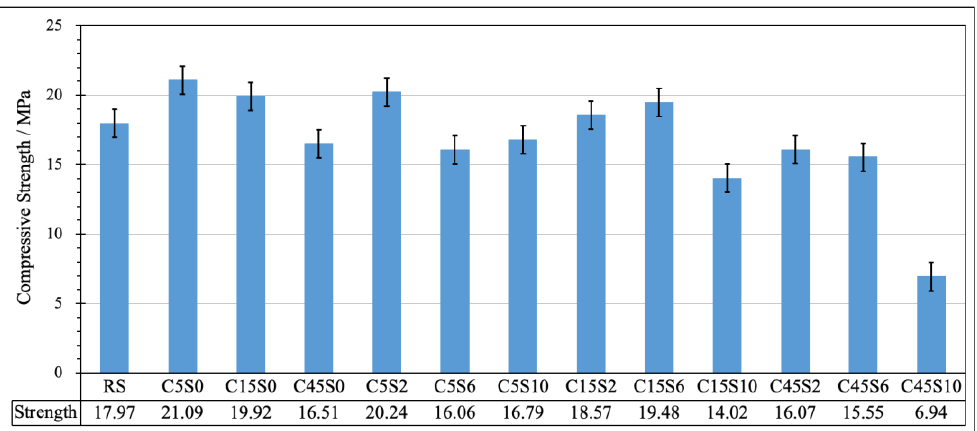
Figure 6. Compressive strength of LWCM.